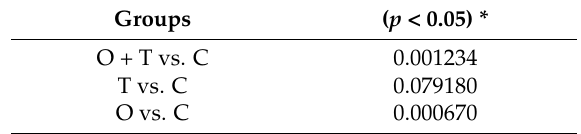
Table 5. Mann-Whitney post-hoc statistical test for the MSCs